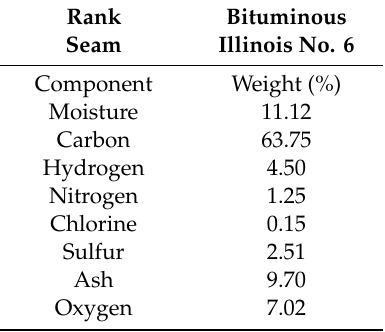
Table 3. Bituminous coal composition.